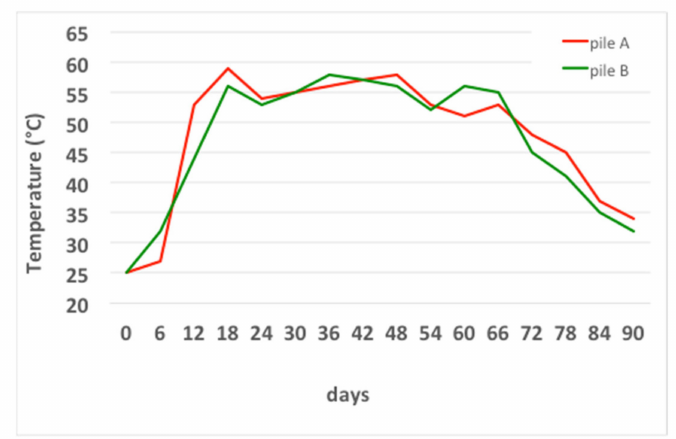
Figure 5. Temperature temporal variation in the compost windrows.